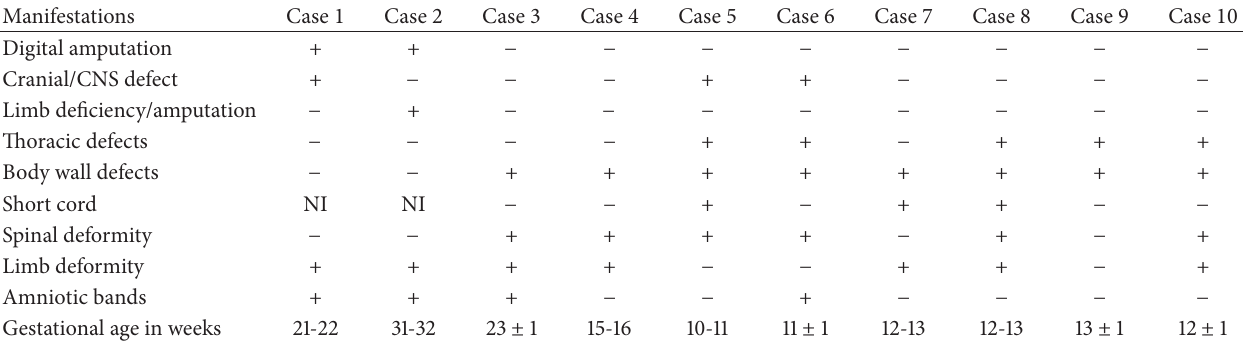
Amniotic bands Gestational age in